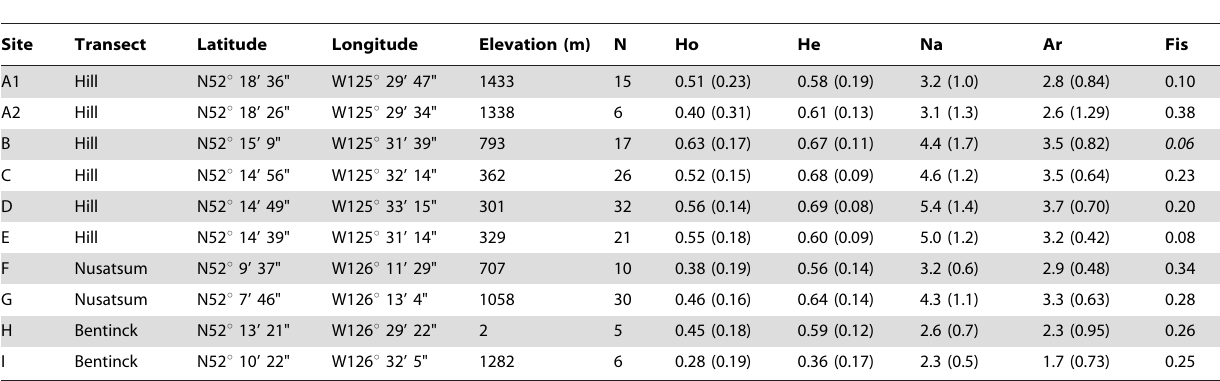
Table 1. Site-specific information including site names, transect, geographical location, elevation, sample size (N), observed (Ho) and expected (He) heterozygosites, number of alleles (Na), allelic richness (Ar), and within-site inbreeding coefficient (Fis), values in brackets indicate Standard Error.